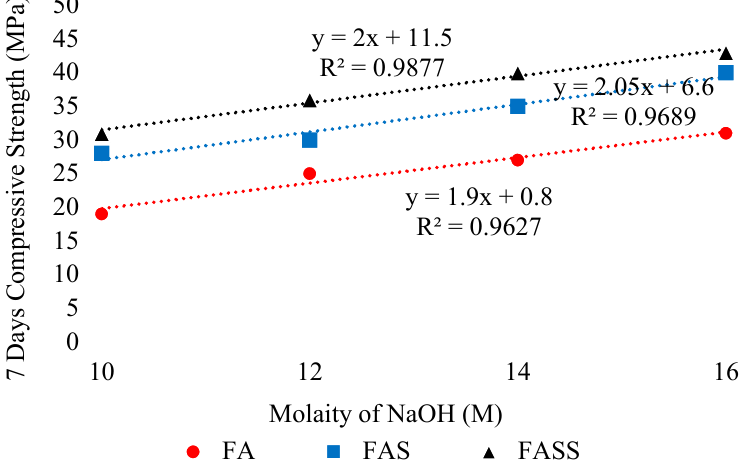
Figure 23. Relationship between molarity and compressive strength, modified from [116]; Elsevier